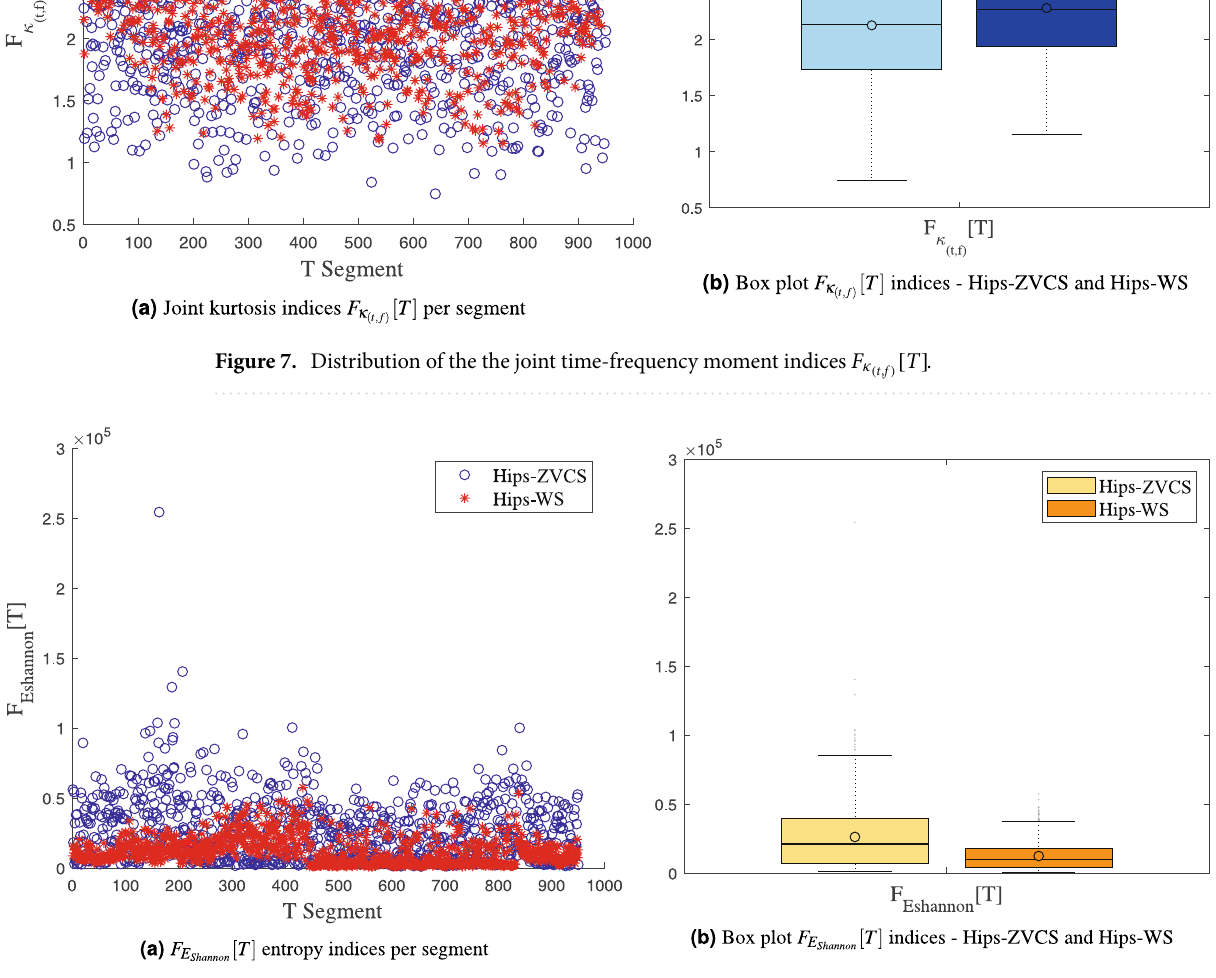
[ T ] entropy measurement Shannon